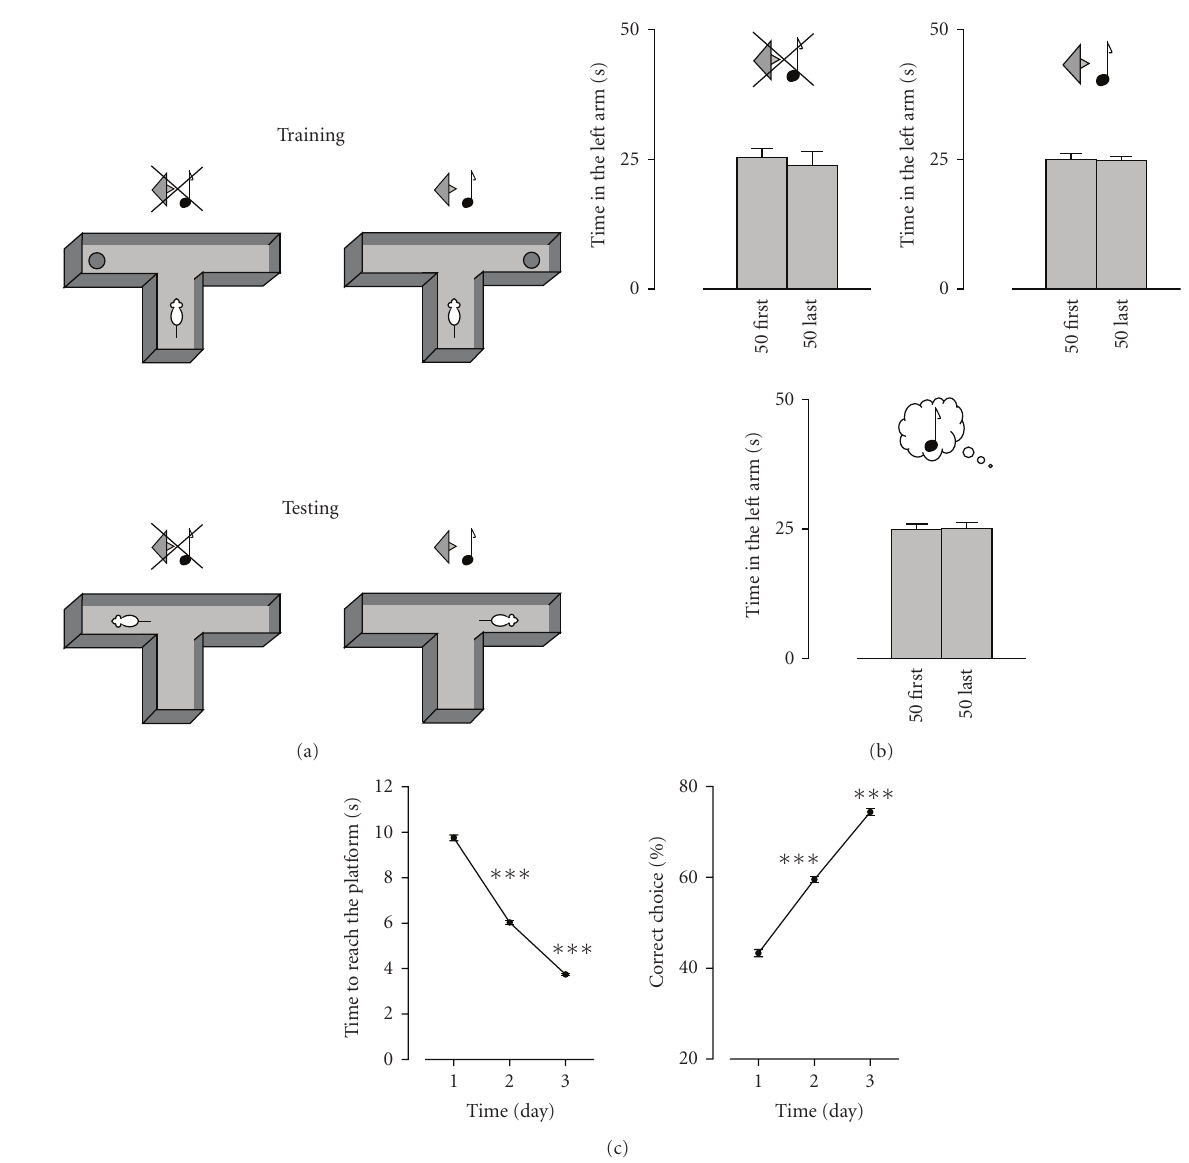
Figure 1: The behavioral paradigm . (a) Schematic description of the task . Rats were conditioned to associate the location of a submerged platform in a water T-maze (WTM) with the absence or presence of a tone. When the tone was present, the platform was in one arm (tone arm), whereas when the tone was absent, the platform was in the opposite arm (no-tone arm). The sidearm-platform-tone permutations were counterbalanced between subjects within each treatment group to control for potential side preference. In the test, conducted 2 weeks after the end of training, the rat was placed in the maze for 100 seconds in the absence of the platform. The arm entered first by the rat and the time spent in each arm in the first and in the last 50 seconds of the test were recorded. (b) Lack of arm preference in the WTM test in the absence of conditioning. Animals were tested in the absence of the tone (upper panel, n = 8), in the presence of a 10 khz tone (middle panel, n = 8), or in the absence of the tone after salicylate treatment at a dose established to induce tinnitus (300 mg/kg/day for 4 days, tested 2 hours after the last administration, lower panel, n = 8). (c) Learning curves of the acquisition of the tone-platform association . Acquisition of the tone-platform association, expressed in time to reach the platform and in percent time spent in the correct arm, each averaged per training day ( n = 124, ∗∗∗ P < .001 compared to the previous training